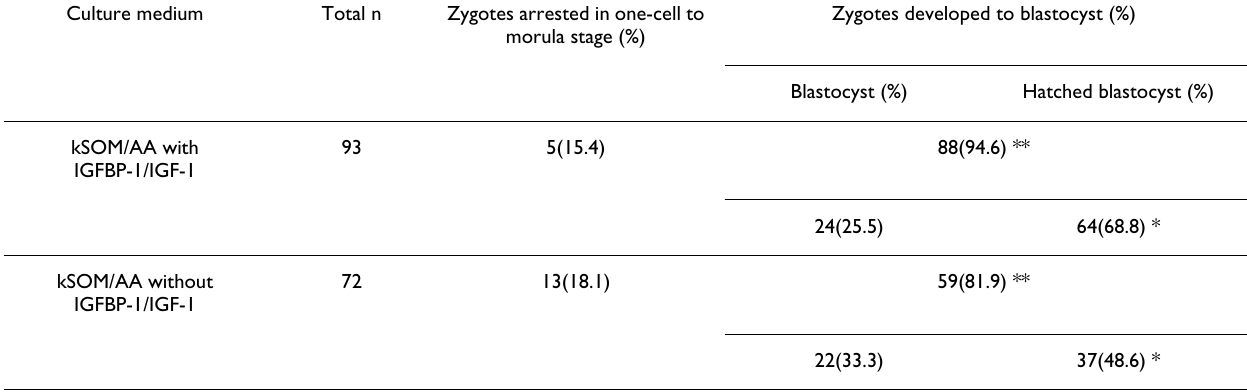
Table 3: The effect of dephosphorylated IGFBP-1/IGF-1 complex upon the developmental competence of in vivo fertilized mouse zygotes. Culture medium